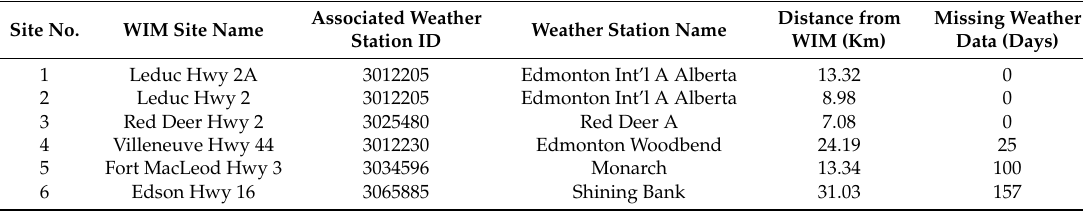
Table 1. Information on WIM Sites and their associated weather station. Site